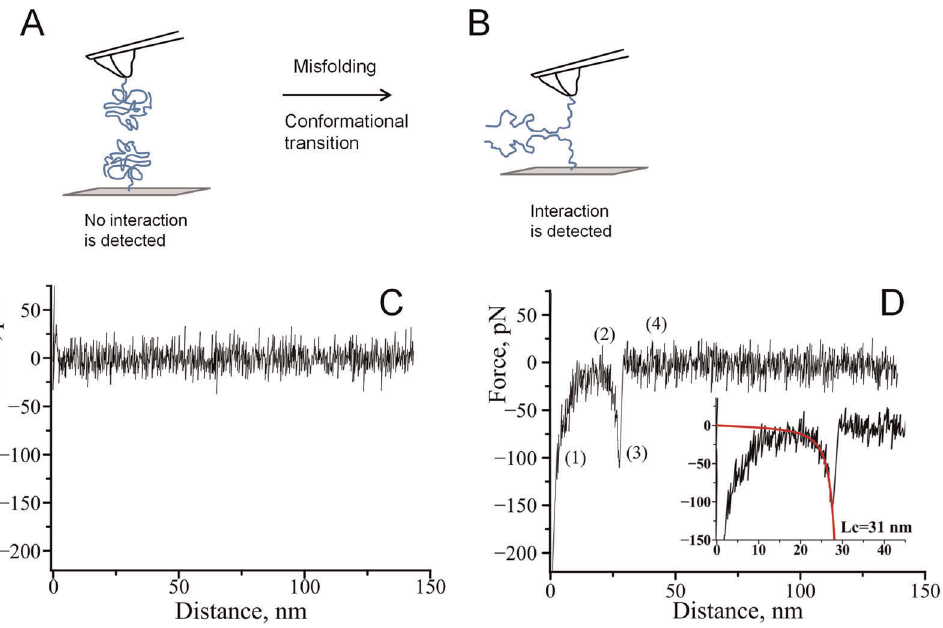
Figure 1. Schematic representation of the experimental approach. A) The unstructured form of alpha-synuclein immobilized on the tip and a substrate reveals no interaction. B) Misfolding of alpha-synuclein results in the formation of aggregation-prone conformation with elevated propensity of intermolecular interactions. C) A representative force-distance curve measured in the absence of spermidine. D) A representative force –distance curve with a rupture event in the presence of spermidine: (1) an adhesion peak due to short-range non-specific interactions between the tip and the surface, (2) gradual increase in force characteristic of polymer stretching, (3) complete rupture at 110 pN and (4) region where tip comes free from the surface. The inset shows worm-like chain fitting yielding contour length of 31 nm.